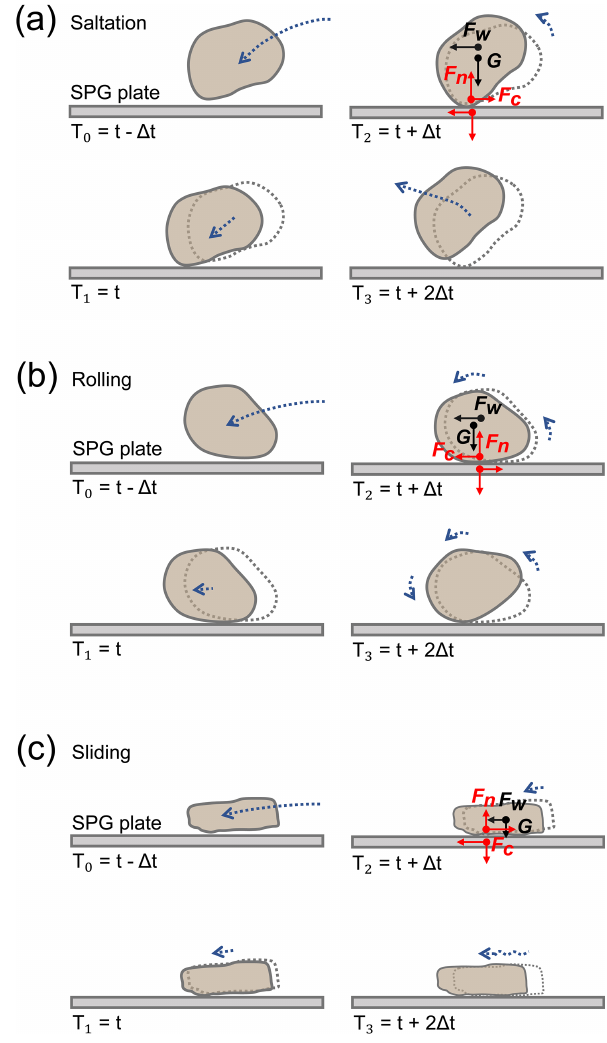
Figure 4. Schematic illustration of the three observed types of transport modes: (a) saltation, (b) rolling, and (c) sliding. T 0 , T 1 , T 2 , and T 3 are four different time instants during particle motion that indicate the impact and rebound of a particle on the SPG plate. In particular, T 2 is the instant when the bedload particle impacts on the SPG plate. F c and F n denote the frictional force and the verti- cal support force exerted by the SPG plate on the bedload particle, respectively. F w is the force from water acting on the bedload par- ticle. G is the force due to the particle’s